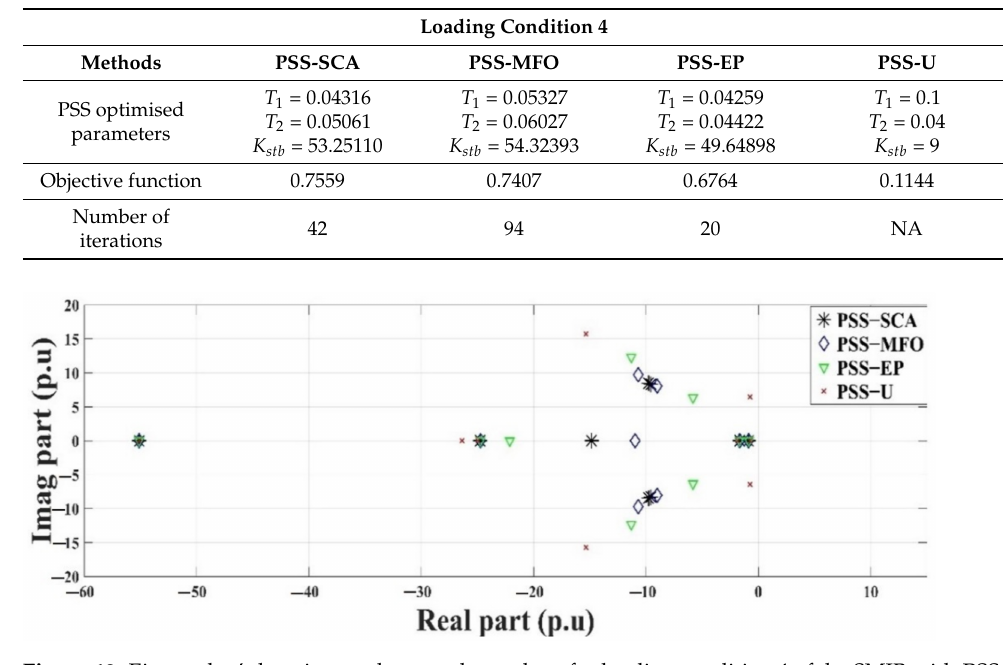
Figure 12. Eigenvalue’s location on the complex s-plane for loading condition 4 of the SMIB with